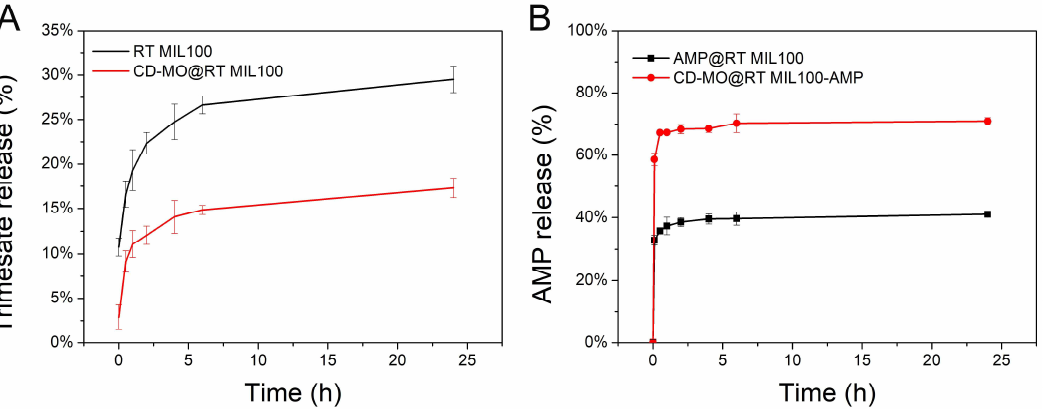
Figure 6. ( A ) Trimesate release from RT MIL100 and CD-MO@RT MIL100 in 1 mM PBS at 37 °C; ( B ) AMP release from AMP@RT MIL100 and CD-MO@RT MIL100-AMP in 1 mM PBS at 37 °C.